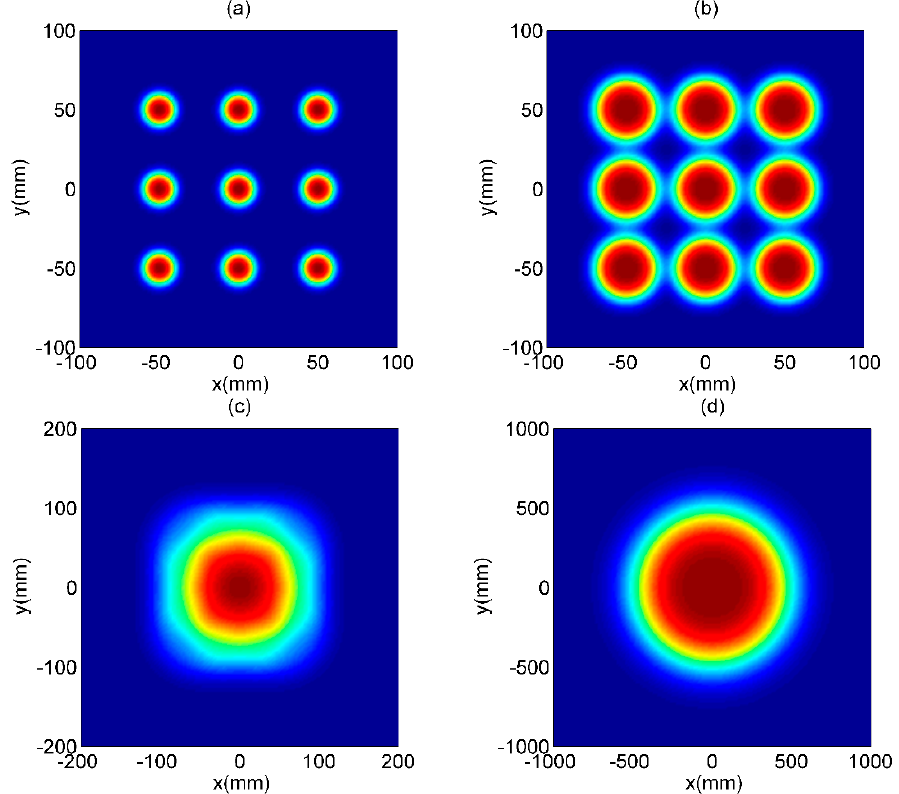
Figure 2. The contour graphs of N × D MGSM array beams propagating through free space with N = D = 3. ( a ) z = 100 m, ( b ) z = 200 m, ( c ) z = 600 m, and ( d ) z = 5000